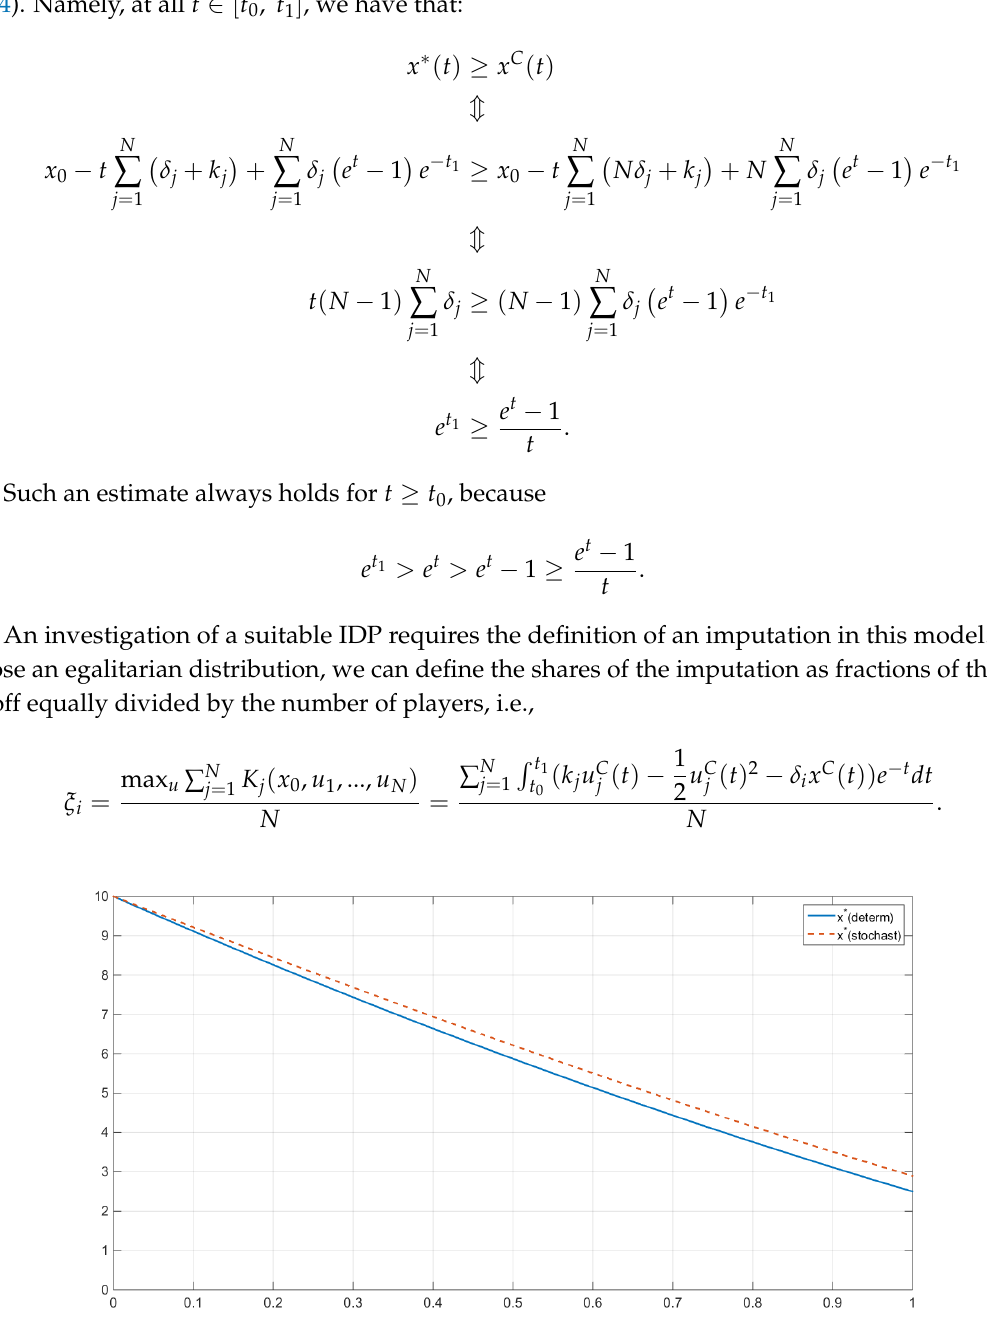
Figure 3. Comparison between deterministic and stochastic settings for state x ∗ ( t )